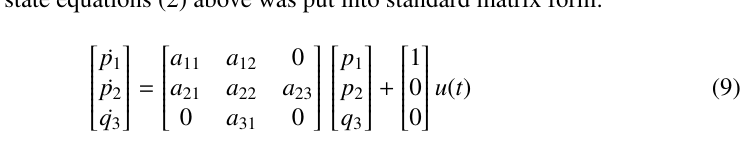
from the acausal bond graph of Fig. 5, one can derive the bond graph of the one stage